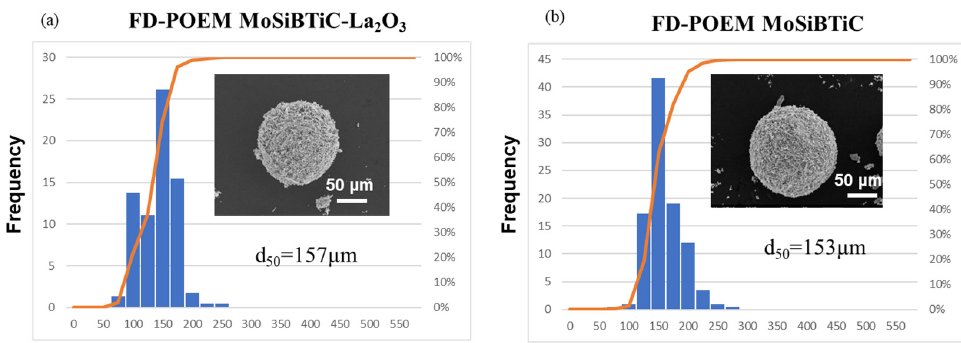
Figure 2. Particle size distributions of the ( a ) MoSiBTiC-La 2 O 3 and ( b ) MoSiBTiC powders. Insets show the SEM images of corresponding FD-POEM particles.